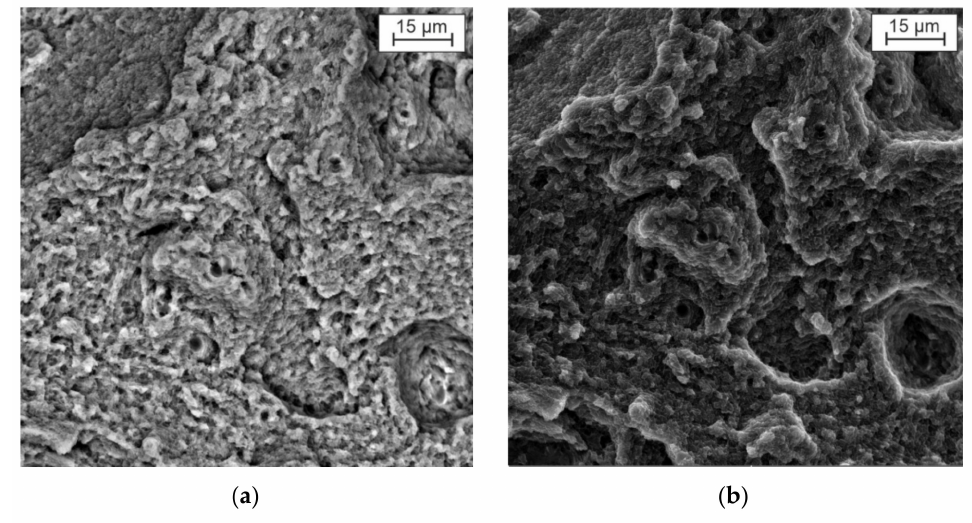
Figure 10. BSE ( a ) and SE ( b ) image of the fracture cross-section Based on the results of metallographic studies and strength tests of samples synthe- sized in optimized modes and using a modified 3D model, the gearbox housing was grown.